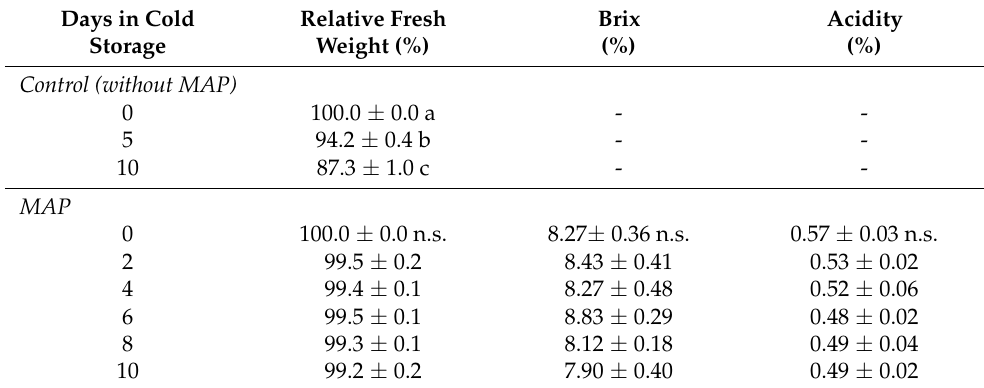
Each value is expressed as mean ± standard error ( n = 4–6). Different letters show significant ( p <